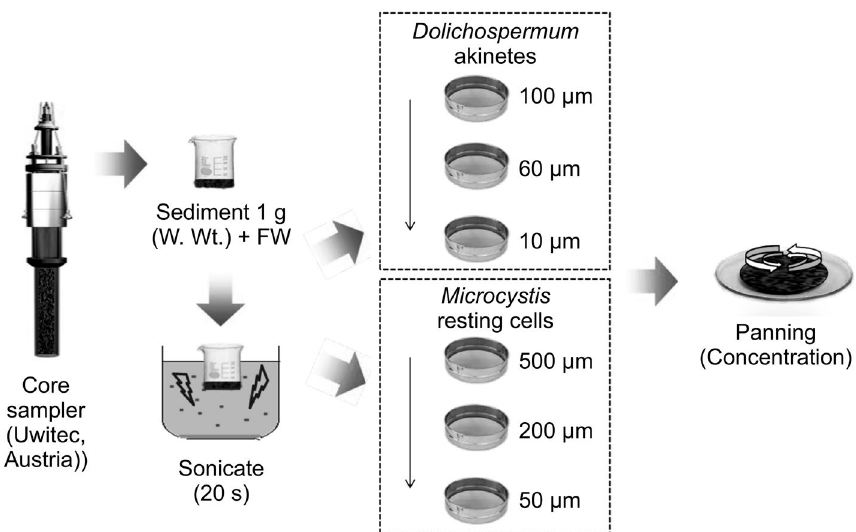
Fig. 2 Separation of akinetes and resting cells using a core sampler. W. Wt.